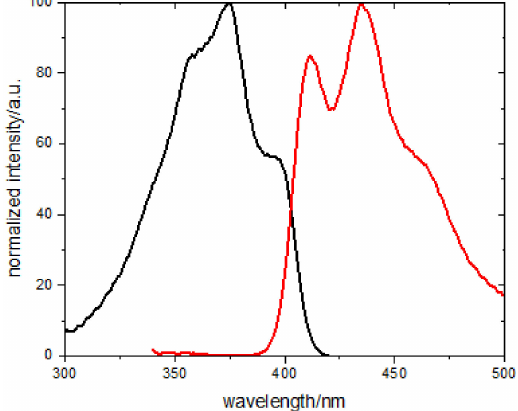
Figure 5. Excitation ( λ em = 435 nm, black line) and emission ( λ ex = 325 nm, red line) spectra of Bpy-SH@AuNR in water